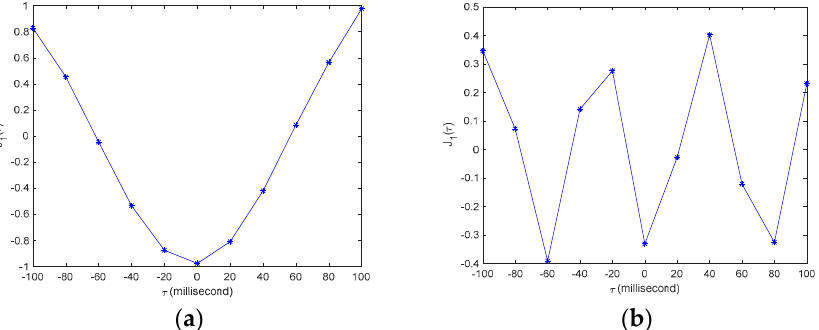
Figure 18. Time synchronization indexes J 1 ( τ ) of cantilever beams: ( a ) beam length = 60 cm; ( b ) beam length = 20 cm.